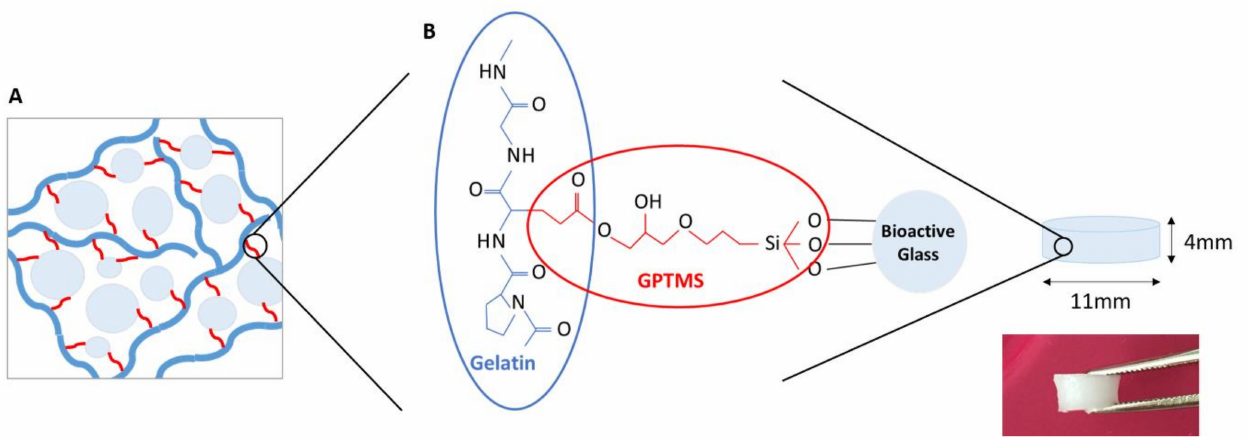
Figure 1. (A ) Schematic representation (inspired from Mahony et al. [18]) and ( B ) chemical structure of the hybrid made of gelatin and bioactive glass (BAG) covalently linked by 3-glycidoxypropyltrimethoxysilane